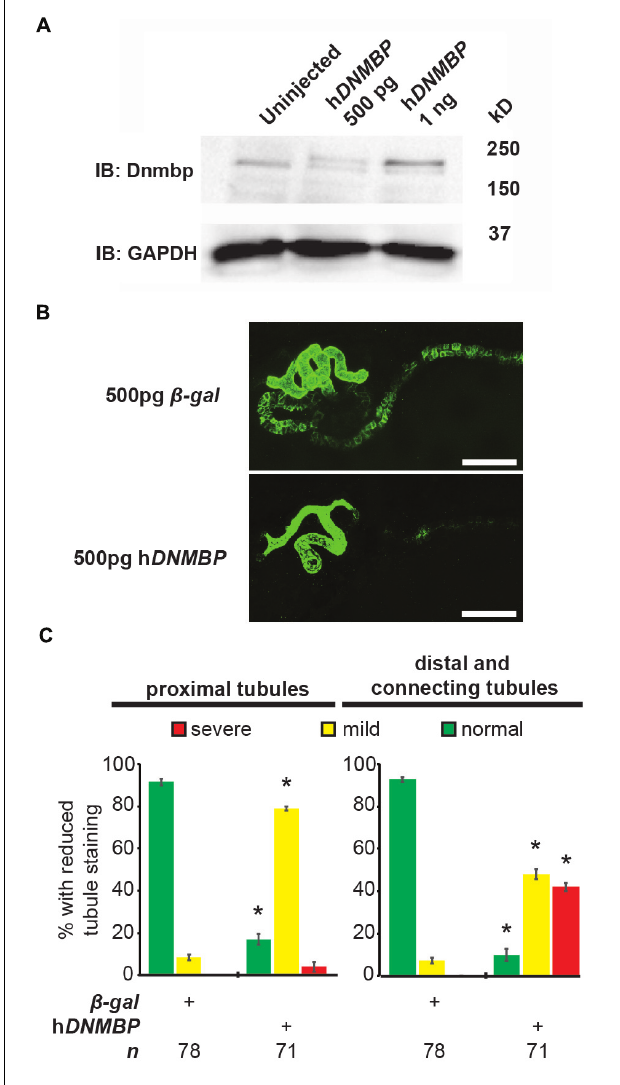
FIGURE 7 | Overexpression of human DNMBP results in kidney tubule defects. (A) Western blot showing expression of both endogenous ( Xenopus ) Dnmbp (lower band) and exogenous (human) HA::DNMBP (upper band). Embryos injected at the one-cell stage and assayed at stage 10–12. One embryo equivalent loaded per lane. (B) Representative stage 40 embryos injected with either β -galactosidase control mRNA or human DNMBP mRNA. Overexpression of h DNMBP leads to disrupted kidney tubulogenesis in comparison to controls. Embryos injected at the 8-cell stage (blastomere V2) to target the kidney and stained with 3G8 antibodies to label the proximal tubule and 4A6 antibodies to label the distal and connecting tubules. White bar indicates 200 µ m. (C) Quantitation of phenotypes showing that overexpression of h DNMBP leads to a reduction in proximal, distal and connecting tubule staining. n = number of embryos across 3 replications. Error bars represent Standard error. ∗ Significantly different from control, p <